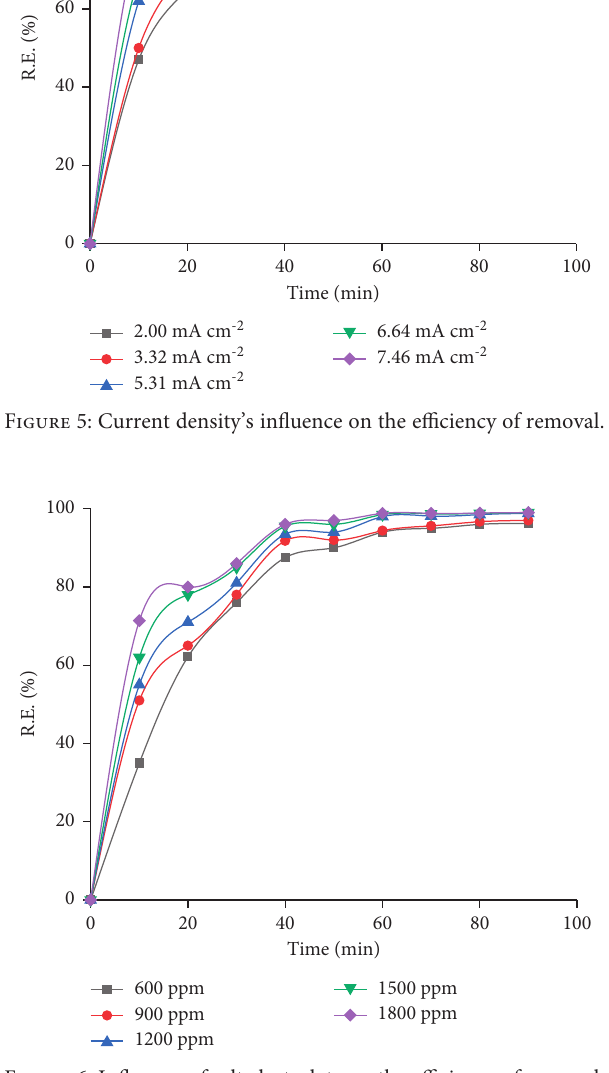
Figure 6: Influence of salt electrolyte on the efficiency of removal.